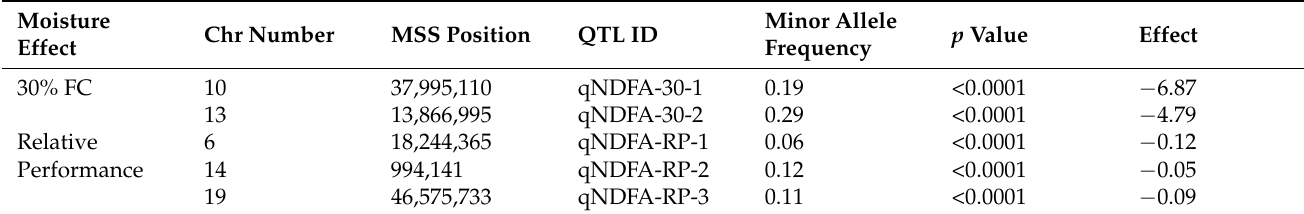
Table 1. List of quantitative trait loci (QTL) associated with percent nitrogen derived from the atmosphere (%Ndfa) under 30% field capacity (FC) and relative performance.